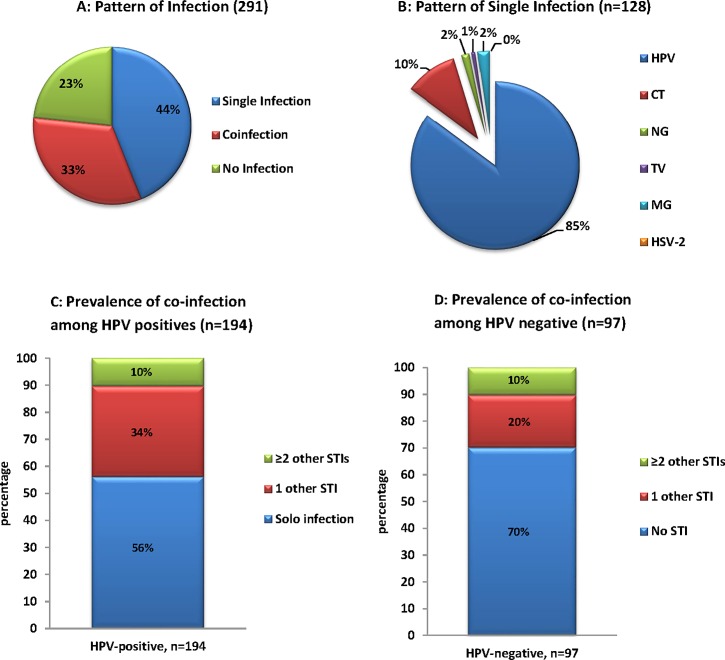
Pattern of sexual transmitted infection among South African adolescents and young women (A) Pattern of single infection (HPV or CT or NG or TV or MG or HSV-2), co-infection with more than one of the six STIs; (B) Pattern of infection among women with one of the six investigated STIs; (C) Prevalence of co-infectionsa among South African adolescents and young women with one or more sexual transmitted infections. a among 194 women that were HPV positive, 56% were positive for HPV only (Solo infection); 34% were co- infected with CT or NG or TV or MG or HSV-2 and 10% were infected with ≥2 other STI; (D) Prevalence of co-infectionsb among South African adolescents and young women with one or more sexual transmitted infections. b among 97 women that were HPV negative, 70% were negative for all tested STIs, 20% were infected with CT or NG or TV or MG or HSV-2 and 10% were infected with ≥2 other STI. HPV: Human papillomavirus. CT: Chamydia trachomatis. NG: Neisseria gonorrhoeae. TV: Trichomanas vaginalis. MG: Mycoplasma genitalium. HSV-2: Herpes simplex virus-2.